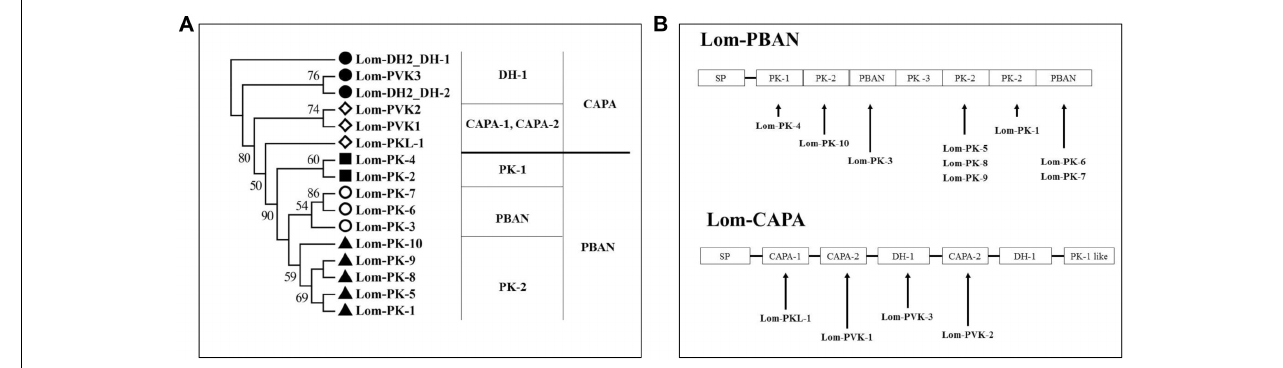
FIGURE 2 | Neuropeptides encoded by capa/phan in Locusta migratoria . (A) Phylogenetic analysis of pyrokinin consensus sequences. (B) Genes of coding neuropeptide; solid line indicates the location of the neuropeptides in the capa/pban